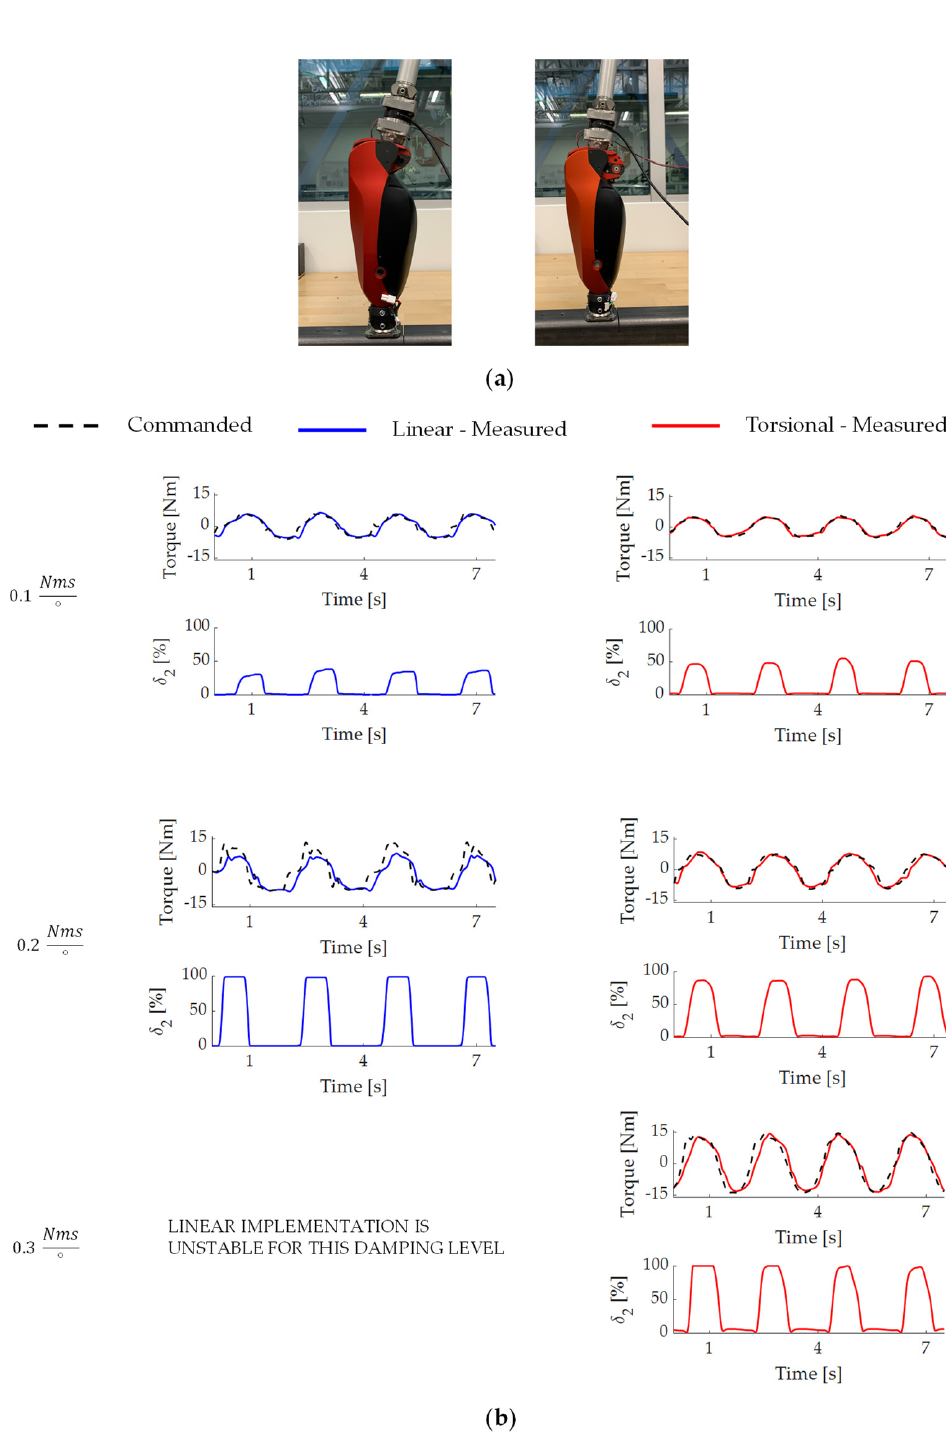
Figure 7. Damping emulation on the bench. ( a ) Experimental setup. A participant used a pylon to manually back-drive the knee joint, which was programmed to act as a damper. ( b ) Commanded and measured output torque, along with movement of the torque-sensitive joint under three differ- ent commanded damping conditions (0.1, 0.2, and 0.3 Nms/°). Results are shown for both imple- mentations.